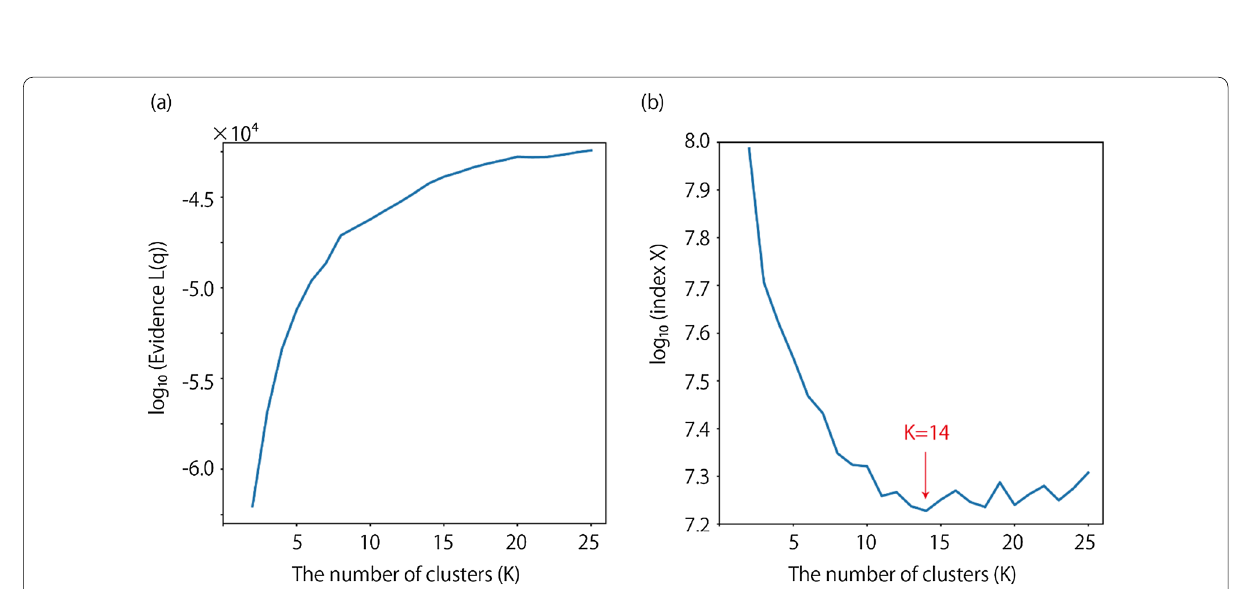
Fig. 10 Grid search results of Evidence L ( q ) and index X for the number of clusters ( K ) at Site